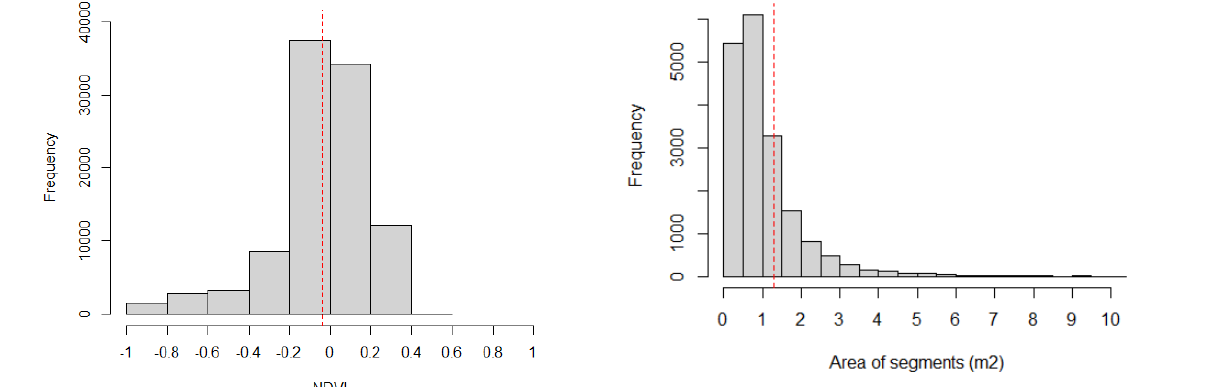
Figure 6. Distribution of NDVI values for the region of interest. Red dashed line is the mean NDVI value